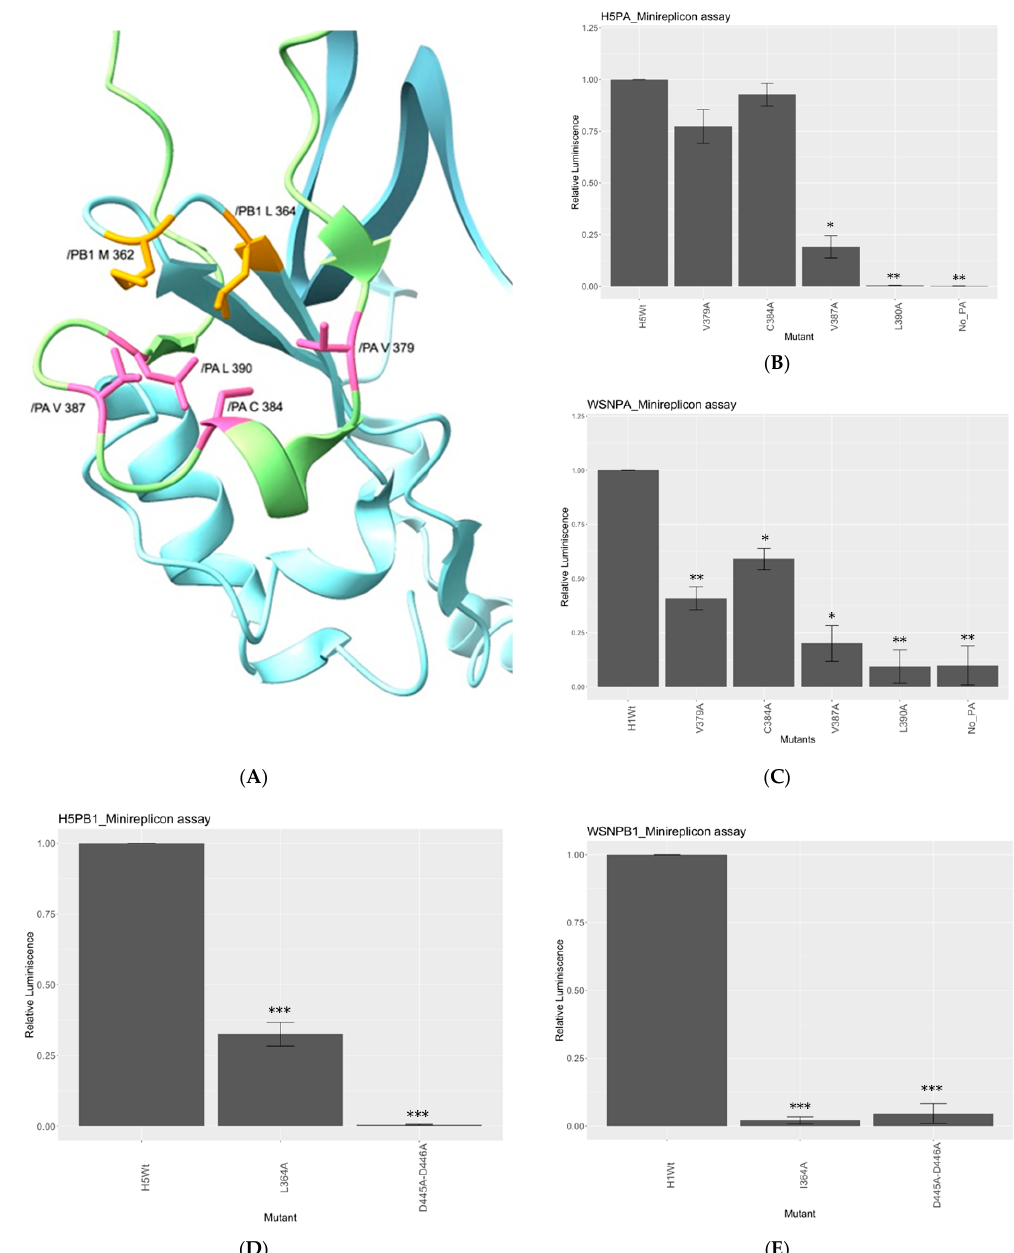
Figure 4. Hydrophobic residues in PA arch interacting with PB1 β -hairpin. ( A ) The proposed hy- drophobic network integrated by the PB1 β -hairpin and the PA arch motif, in which the hydrophobic residues on the PA arch were labelled in pink and those in PB1 labelled orange. The side chains of the mentioned residues were pointing towards the center of the network, suggesting the structural importance of the hydrophobic residues within the network (RCSB ID: 6RR7). The effect of PA alanine mutants on the polymerase activity were determined by minireplicon assay. Activity of PA mutants in 156/97 background ( B ) and the WSN background ( C ) showed a similar trend. RNP cassette without PA was used as negative control in both set-ups. The effect of WSN PB1/I364A and 156/97 PB1/L364A mutants were determined by minireplicon assay. Activity of L364A in 156/97 background ( D ) reported an about 70% decrement in polymerase activity, while I364A in WSN background ( E ) defected the RNP activity. D445A-D446A was used as the negative control in both set-ups. Student’s t -test was performed to determine the p -value. * = p value < 0.05; ** = p value <0.01; *** = p value <